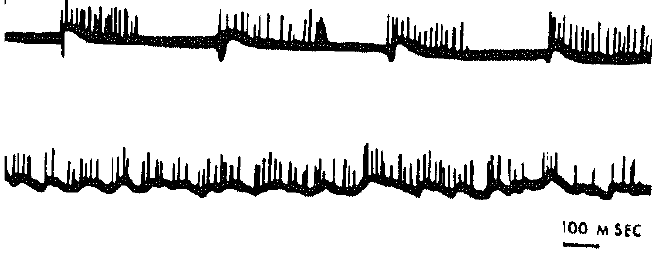
Figure 5. Examples of all-or-none responses triggered in different preparations or at different recording sites by electrical stimulation in organotypic mouse medulla